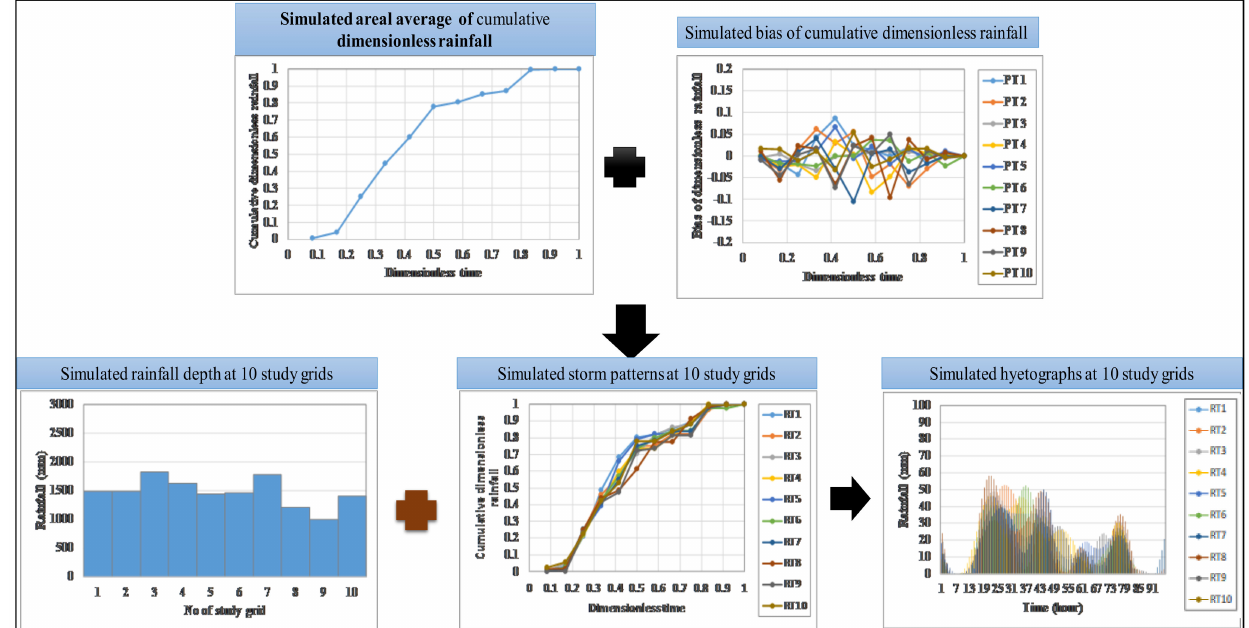
Figure 2. Graphical process of combining the simulated gridded rainfall characteristics as the gridded rainstorms